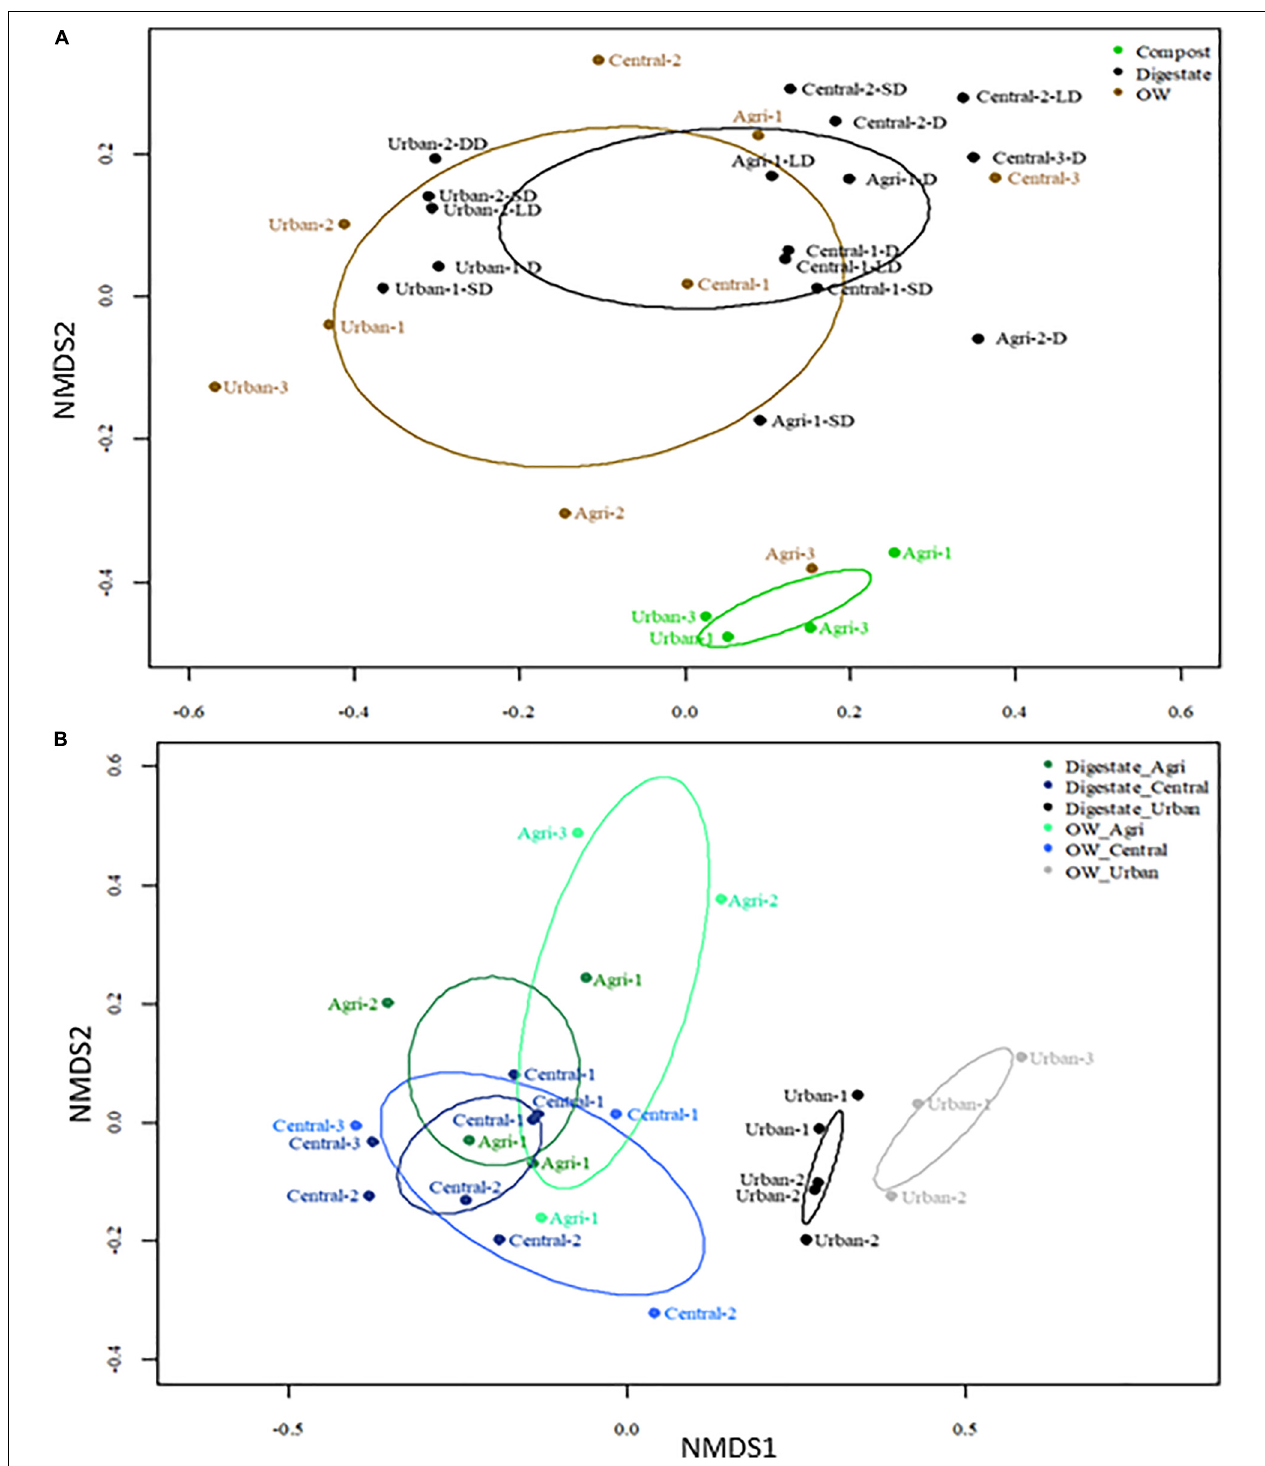
FIGURE 2 | Non-metric multidimensional scaling (NMDS) plot of Bray–Curtis dissimilarities computed from the 16S rRNA V5–V6 OTU profiles (subsampled, 97% identity) of the organic samples before (raw OW) and after treatment by anaerobic digestion or composting. (A) NMDS ordinations were built from the full dataset shown in Table 1 ; stress value was 0.1227. (B) NMDS ordinations were built from a dataset limited to raw OW and digestates. The ellipses indicate the variance observed within each group of samples. PERMAMOVA tests are indicated in the text and confirmed the significance ( p < 0.05) of several groupings.